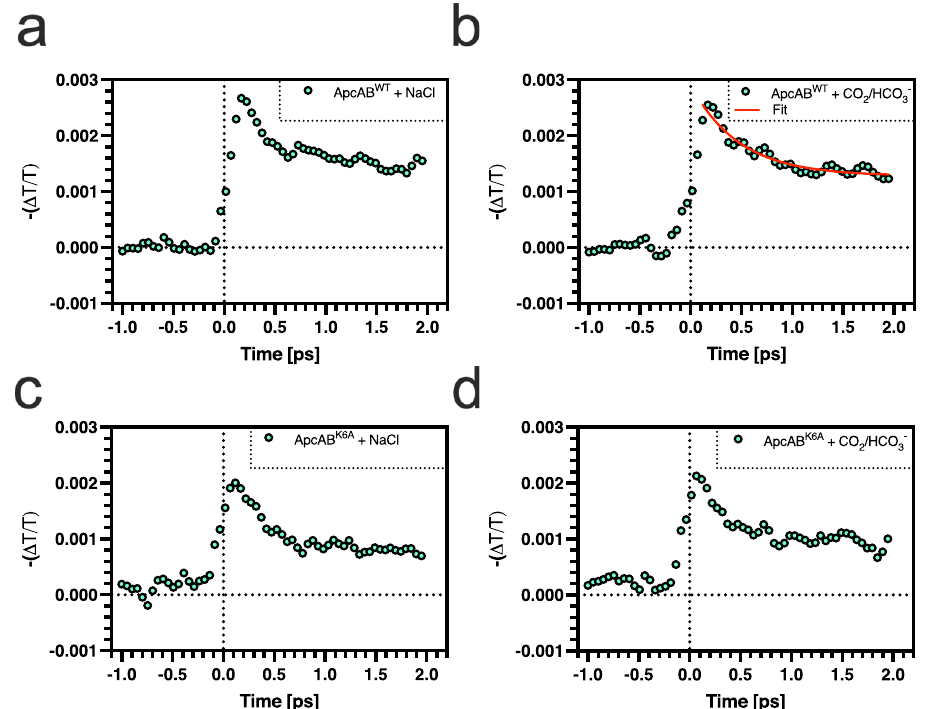
Fig. 4 | CO 2 enhancesthe Synechococcus sp. PCC 7002 ApcAB EET rate in vitro. A plotofthechangeintransmissionversustimeforApcAB WT ( αβ ) 3 ( a , b )orApcAB K6A ( αβ ) 3 ( c , d ) trimers in the presence of NaCl ( a , c ) or CO 2 /HCO 3 − . The sample was